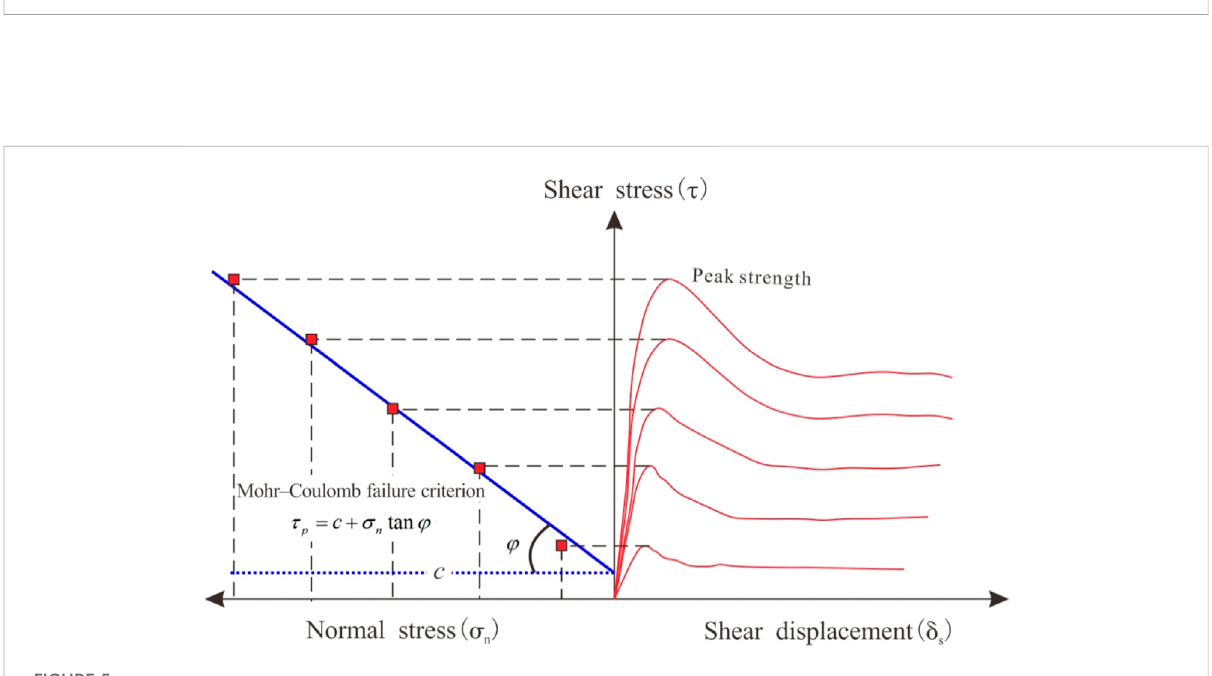
FIGURE 5 Typical presentation of direct shear test results (Muralha et al.,